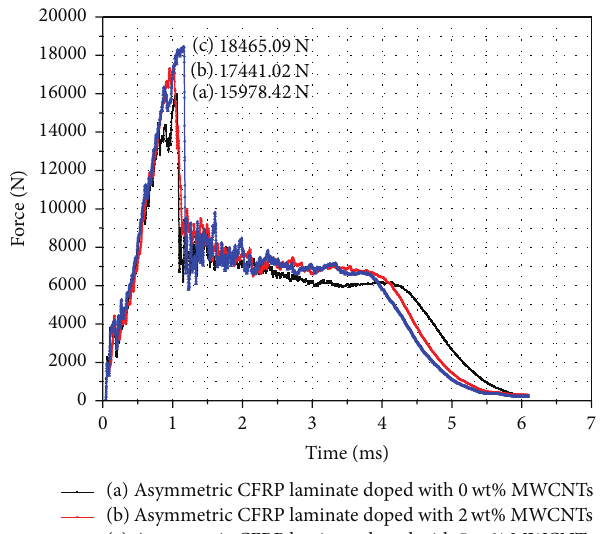
Figure 5: Force-time relations of asymmetric CFRP laminate embedded with 0 wt.%, 2 wt.%, and 5wt.% MWCNTs.